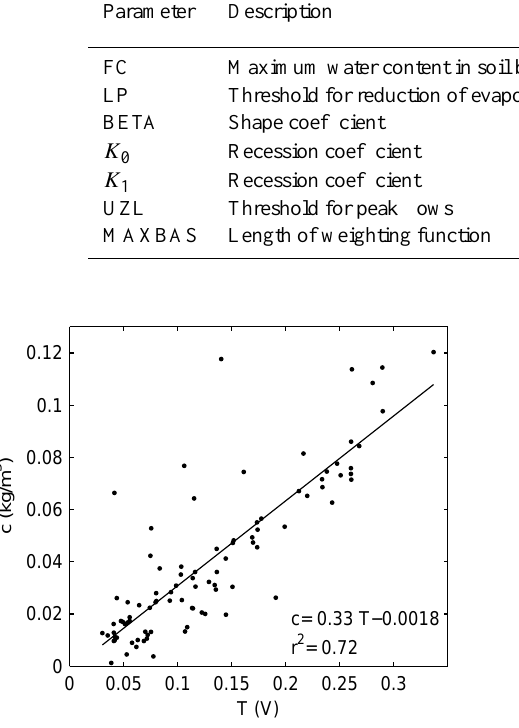
Fig. 5. Calibration of turbidity with total suspended matter ( c ) from in situ water